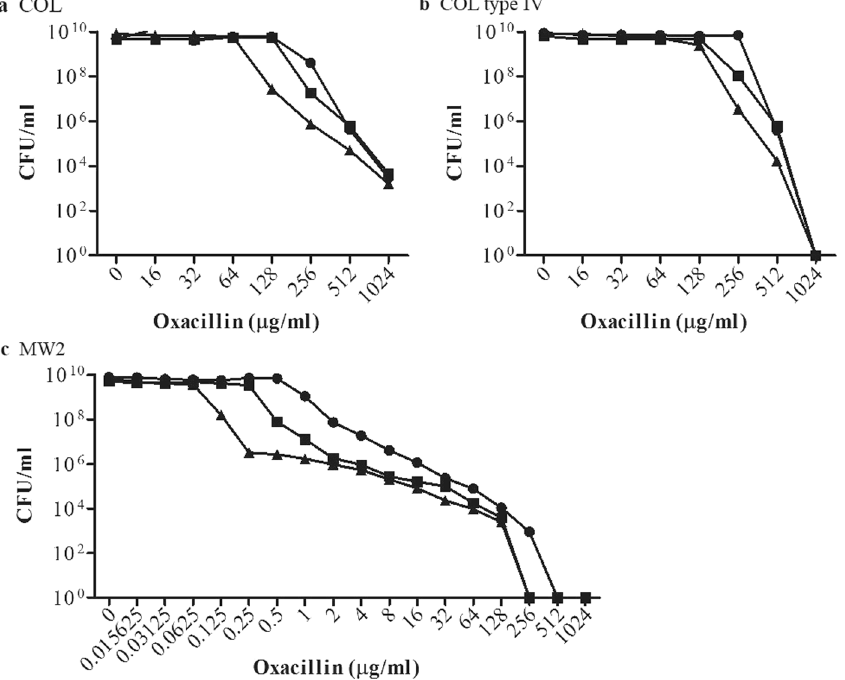
Figure 3. Population Analysis Profiles of S. aureus susceptibility to oxacillin in the presence or absence of cefoxitin. Oxacillin susceptibility was tested in strains ( a ) COL, ( b ) COL type IV, and ( c ) MW2, shown as circles. Corresponding strains lacking PBP4 are represented as squares and strains grown in the presence of ¼ X MIC of cefoxitin are shown as triangles (64 µ g/ml for COL and COL type IV; 8 µ g/ml for MW2). Strains were plated on agar containing twofold dilutions of oxacillin, incubated at 37 °C for 48 h and the number of colony forming units (CFU) per ml was calculated. The experiment was performed in triplicate and a representative graph is shown here.